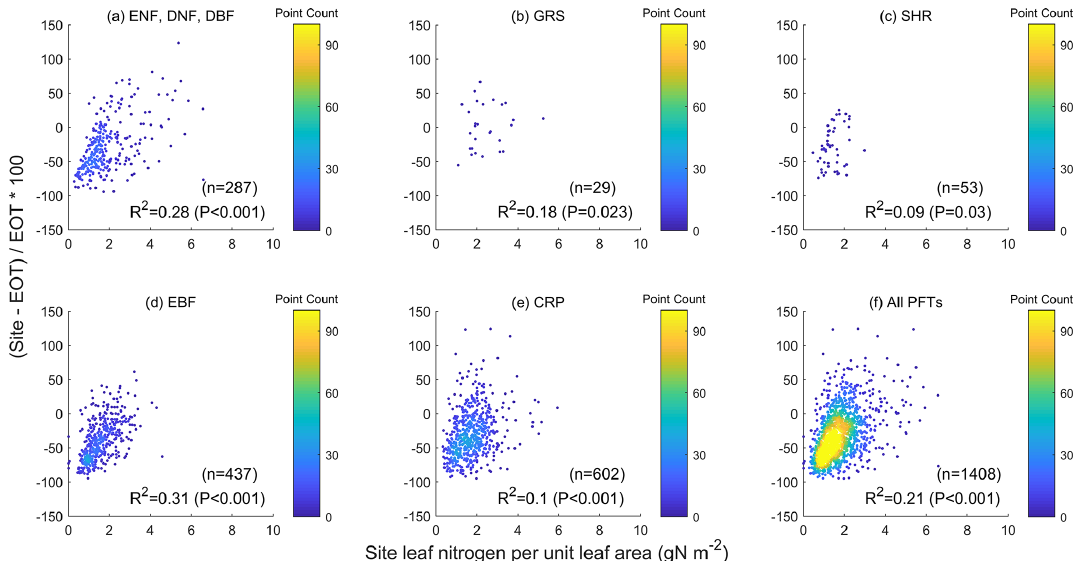
values measured at ground sites and derived from an g